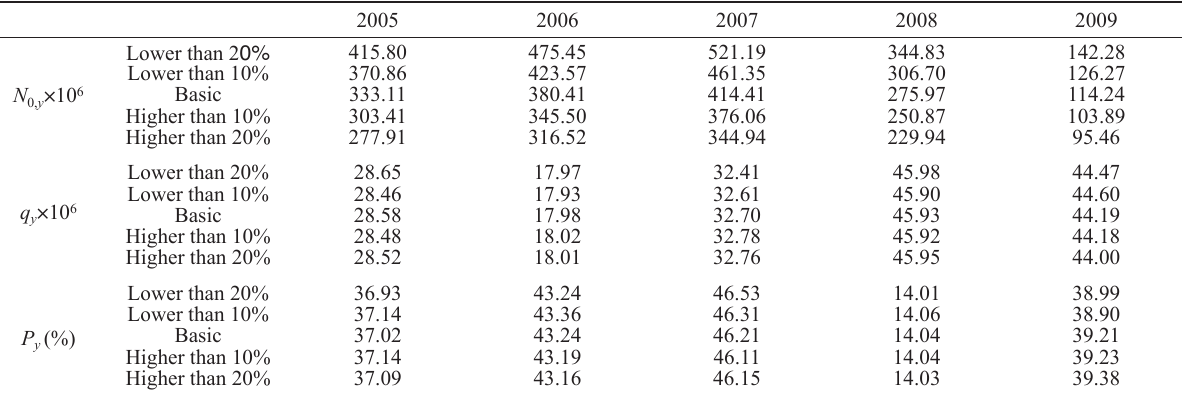
Table 1. – Estimated mean values of initial abundance, catchability coefficient, and proportional escapement of different body weight using a Bayesian hierarchical model with M =0.007. “Basic” refers to body weight values in 2005-2009 calculated on the basis of the derived daily growth function. “Lower than 20%”, “Lower than 10%”, “Higher than 10%”, and “Higher than 20%” refer to body weight values in 2005- 2009 lower than 20%, lower than 10%, higher than 10%, and higher than 20% of the corresponding values calculated on the basis of the derived daily growth function,